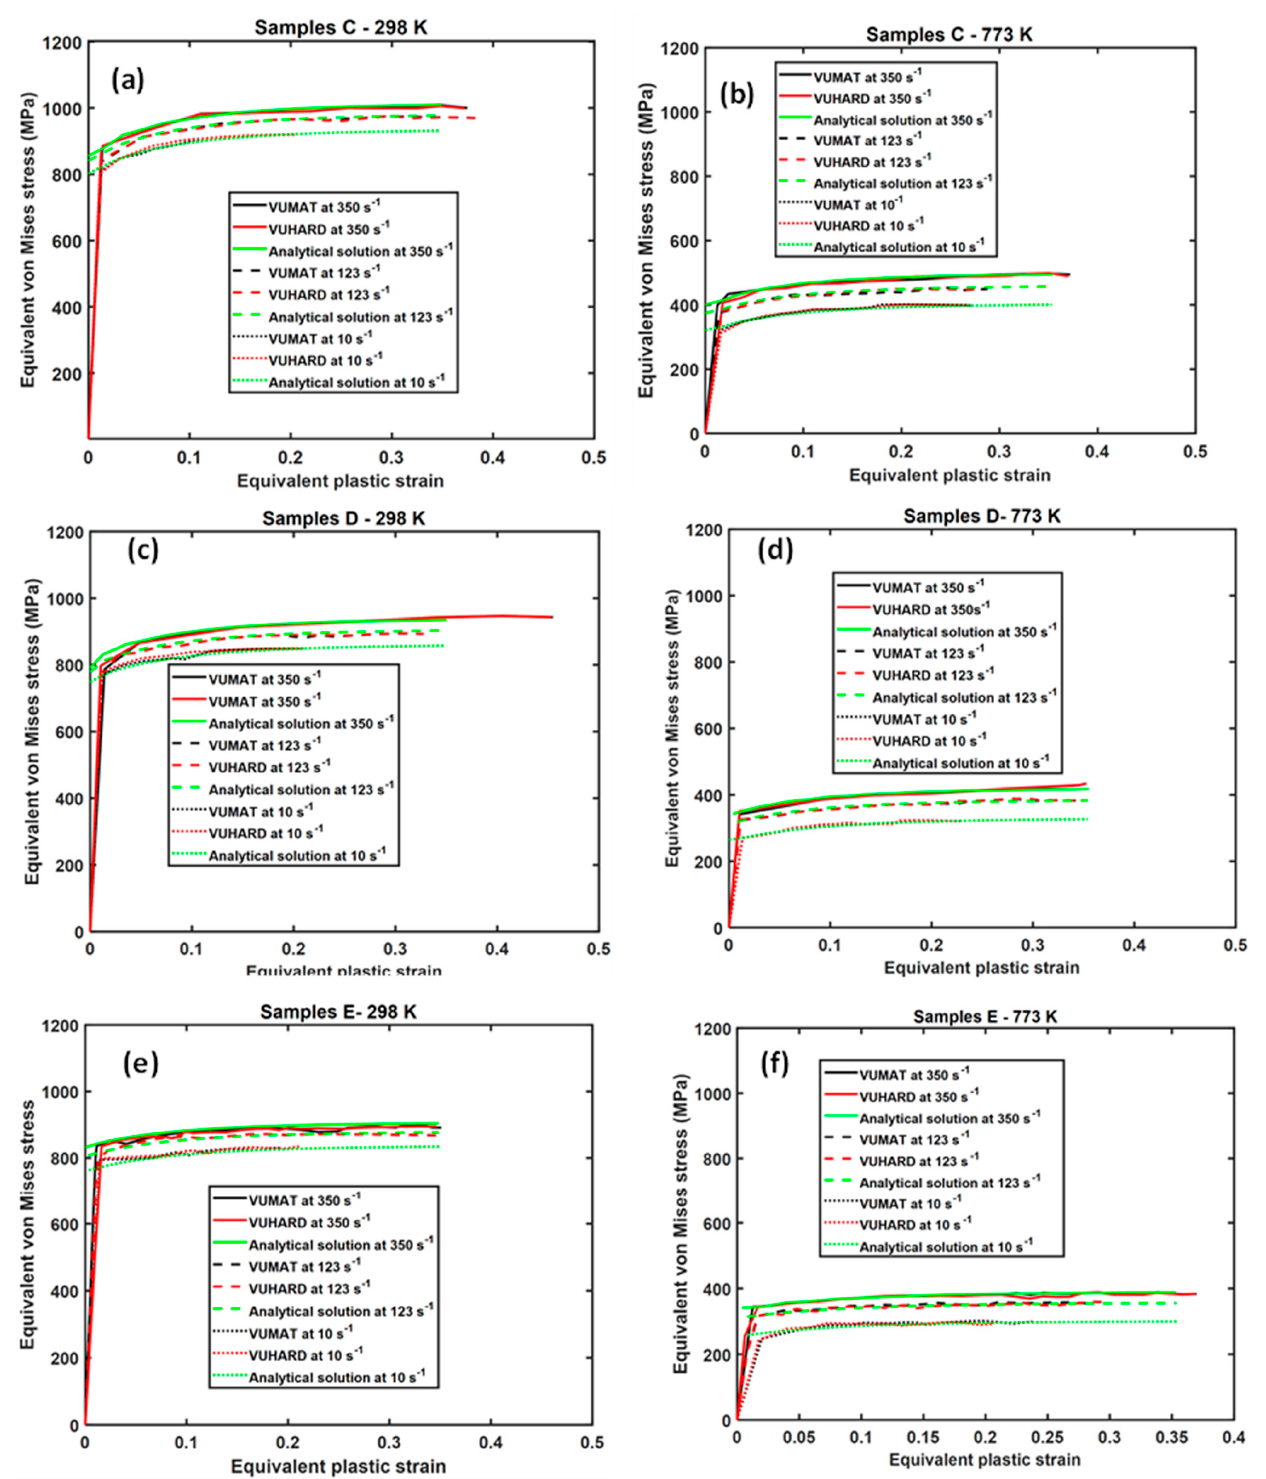
Figure 20. Comparison between the analytical and numerical solutions using the VUMAT and VUHARD subroutines at three test velocities and a temperature of ( a , c , e ) 298 K and ( b , d , f ) 773 K for a multiple element cylindrical model of ( a , b ) samples C, ( c , d ) samples D, and ( e , f ) samples E.